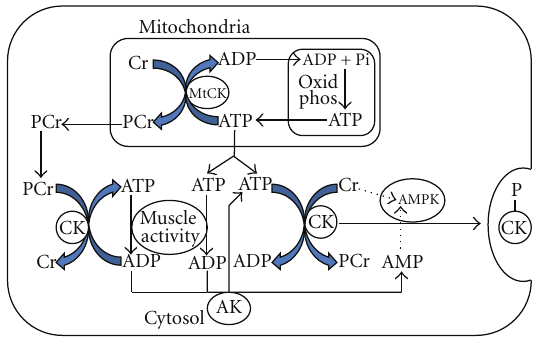
Figure 4: Potential roles of adenylate kinase (AK) and AMP- activated protein kinase (AMPK) in gross control of creatine kinase (CK) activity by promoting expulsion of CK from the cytosol to limit CK utilisation of ATP for PCr resynthesis adapted from Saks